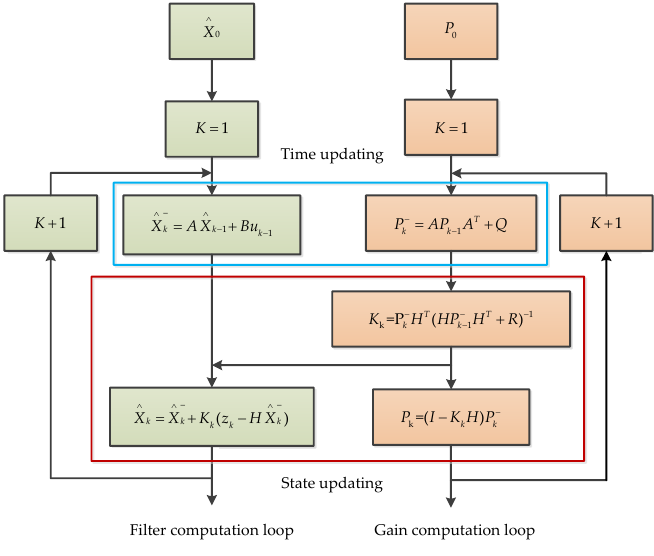
Figure 6. The process of the Kalman filter.